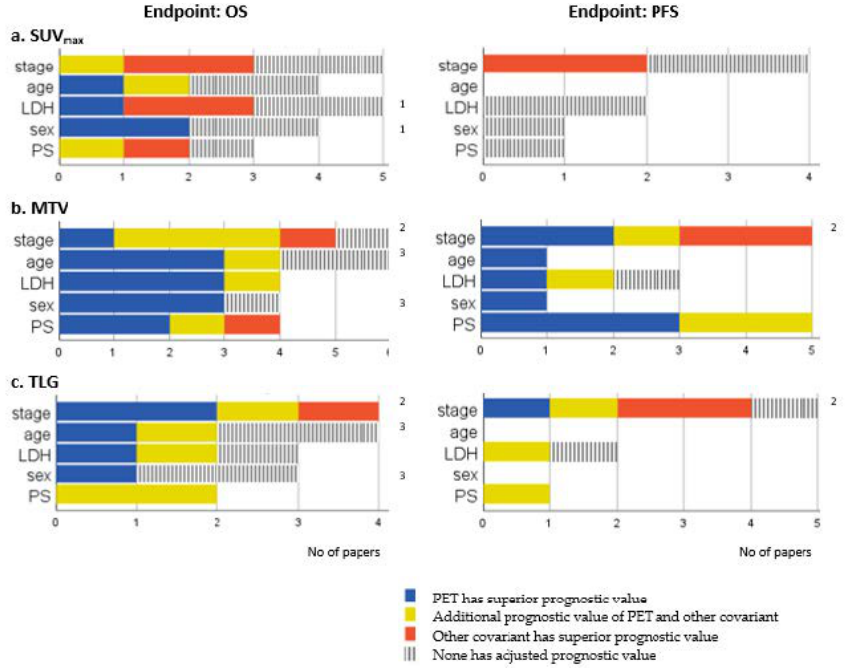
Figure 3. Comparisons of PET parameters and other covariates included in the multivariate analysis. Number of papers showing either superior (blue), additional (yellow), inferior (red), or no prognostic value (grey) of adjusted SUV max ( a ), MTV ( b ), and TLG ( c ) compared with the five most frequently used covariates. 1 Özdemir accounted twice due to different results in subgroups, 2 Nobashi accounted twice due to different results in subgroups, 3 Choi accounted twice due to different results in subgroups.